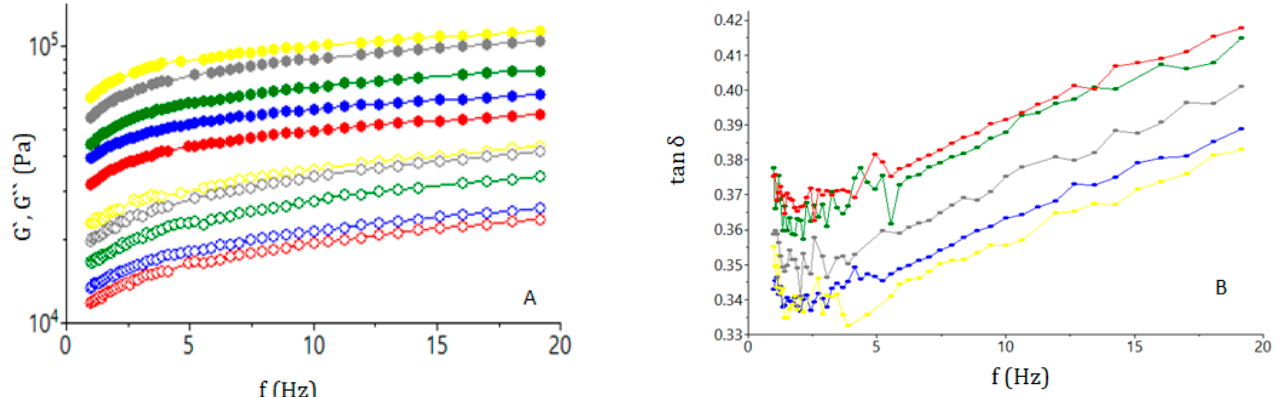
Figure 1. Evaluation with a frequency of G’ (open symbols), G” (solid symbols) ( A ) and tan δ ( B ) for the samples with different levels (-•-0%, -•-5%, -•-10%, -•-15% and -•-20%) of germinated lupine flour (GLF) additions in wheat flour.